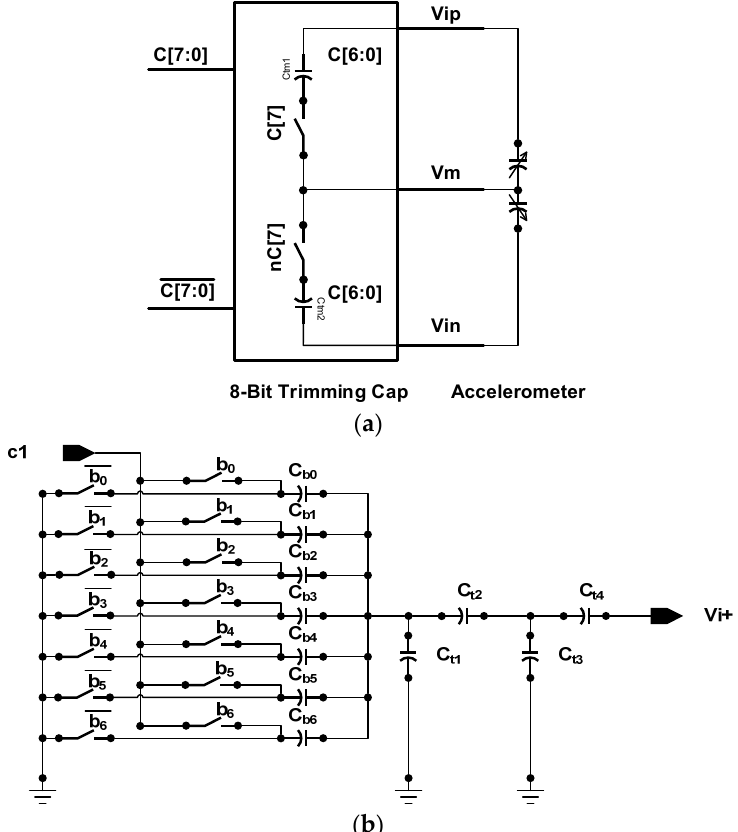
Figure 7. Schematic of 8-bit trimming capacitance: ( a ) The 8-bit trimming capacitor with the CMOS/MEMS accelerometer circuit model; and ( b ) the 7-bit segmented split capacitor structure.